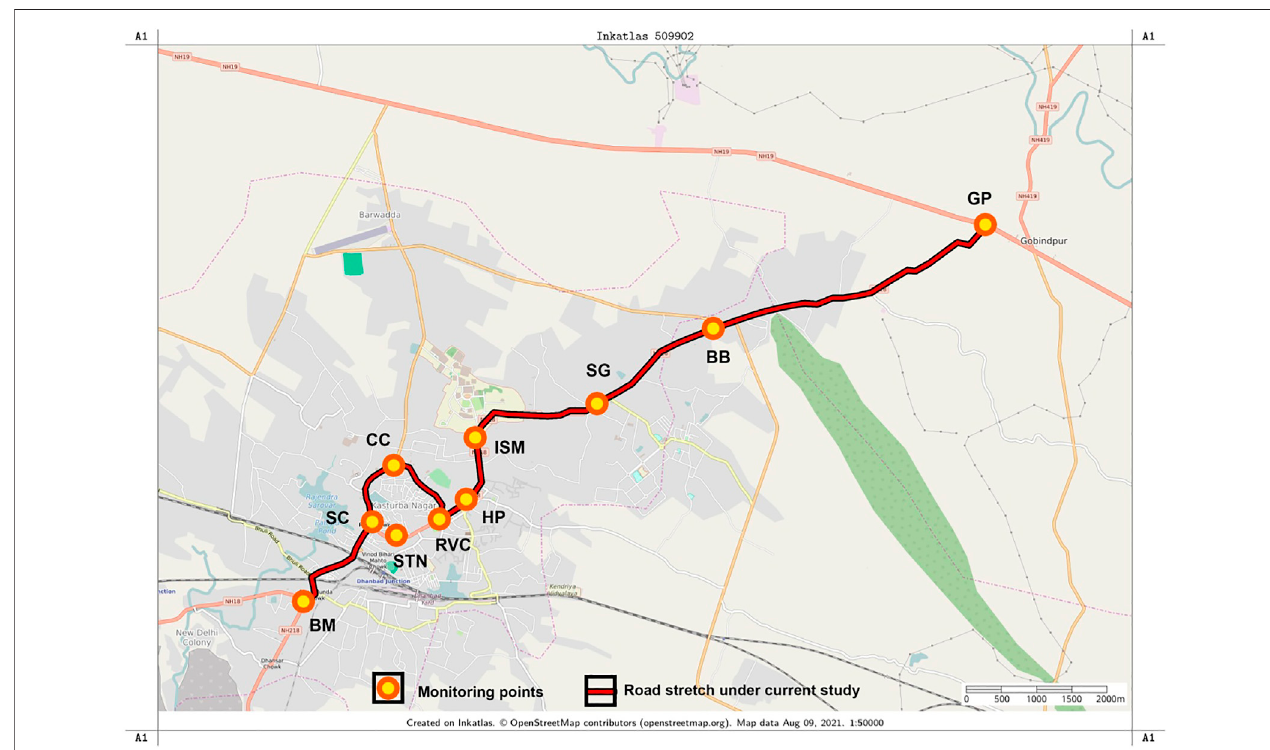
FIGURE 1 | Road map of the study route and location of the monitoring points (base map source: https://www.openstreetmap.org).